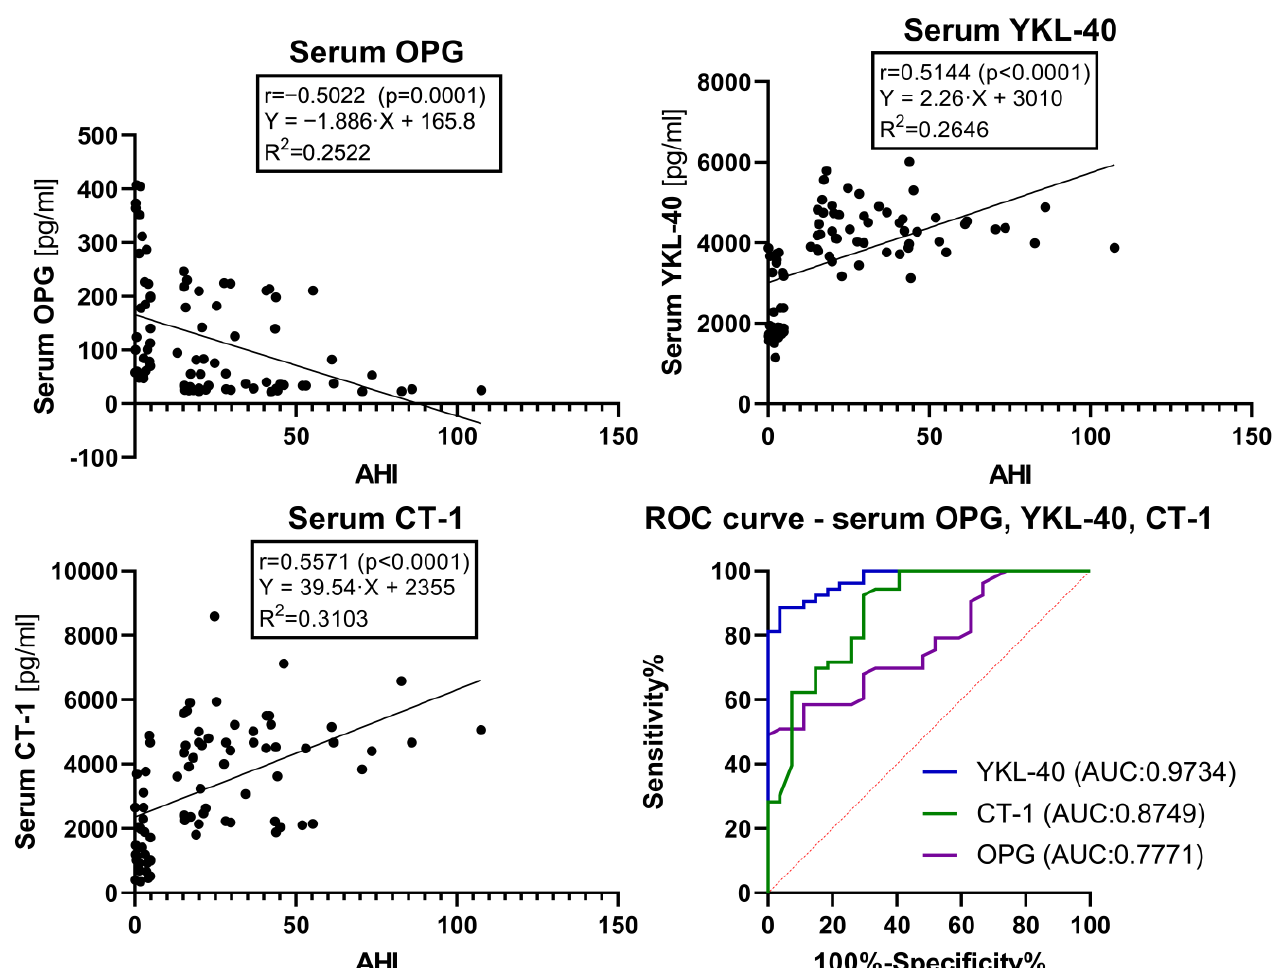
Figure 1. Simple linear regression graphs of the concentrations of OPG, YKL-40, and CT-1 in the serum. ROC curves of the concentrations of OPG, YKL-40, and CT-1 in the serum. The results of Spearman correlation analysis are expressed as r values and the level of statistical significance ( p ).